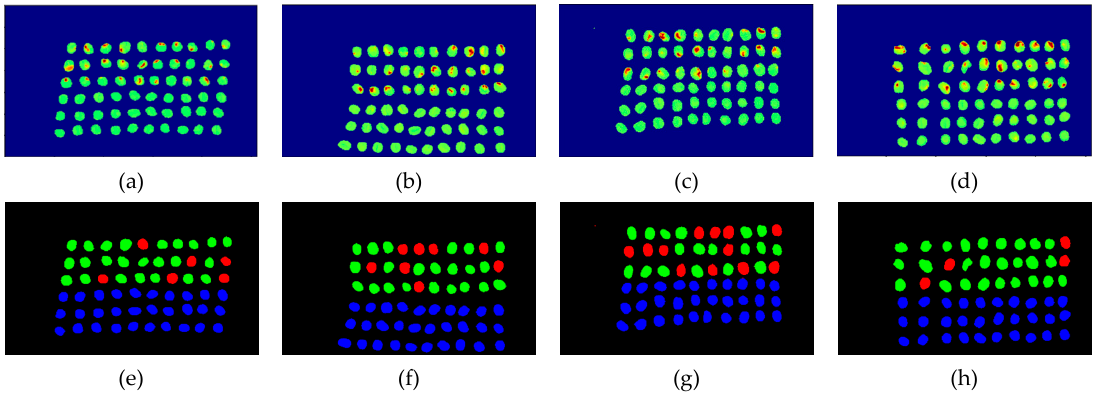
Figure 45. Results of green coffee bean CNN+maxV_BP 20 bands. (a-d) CNN classification results, (e-h) final visual images.